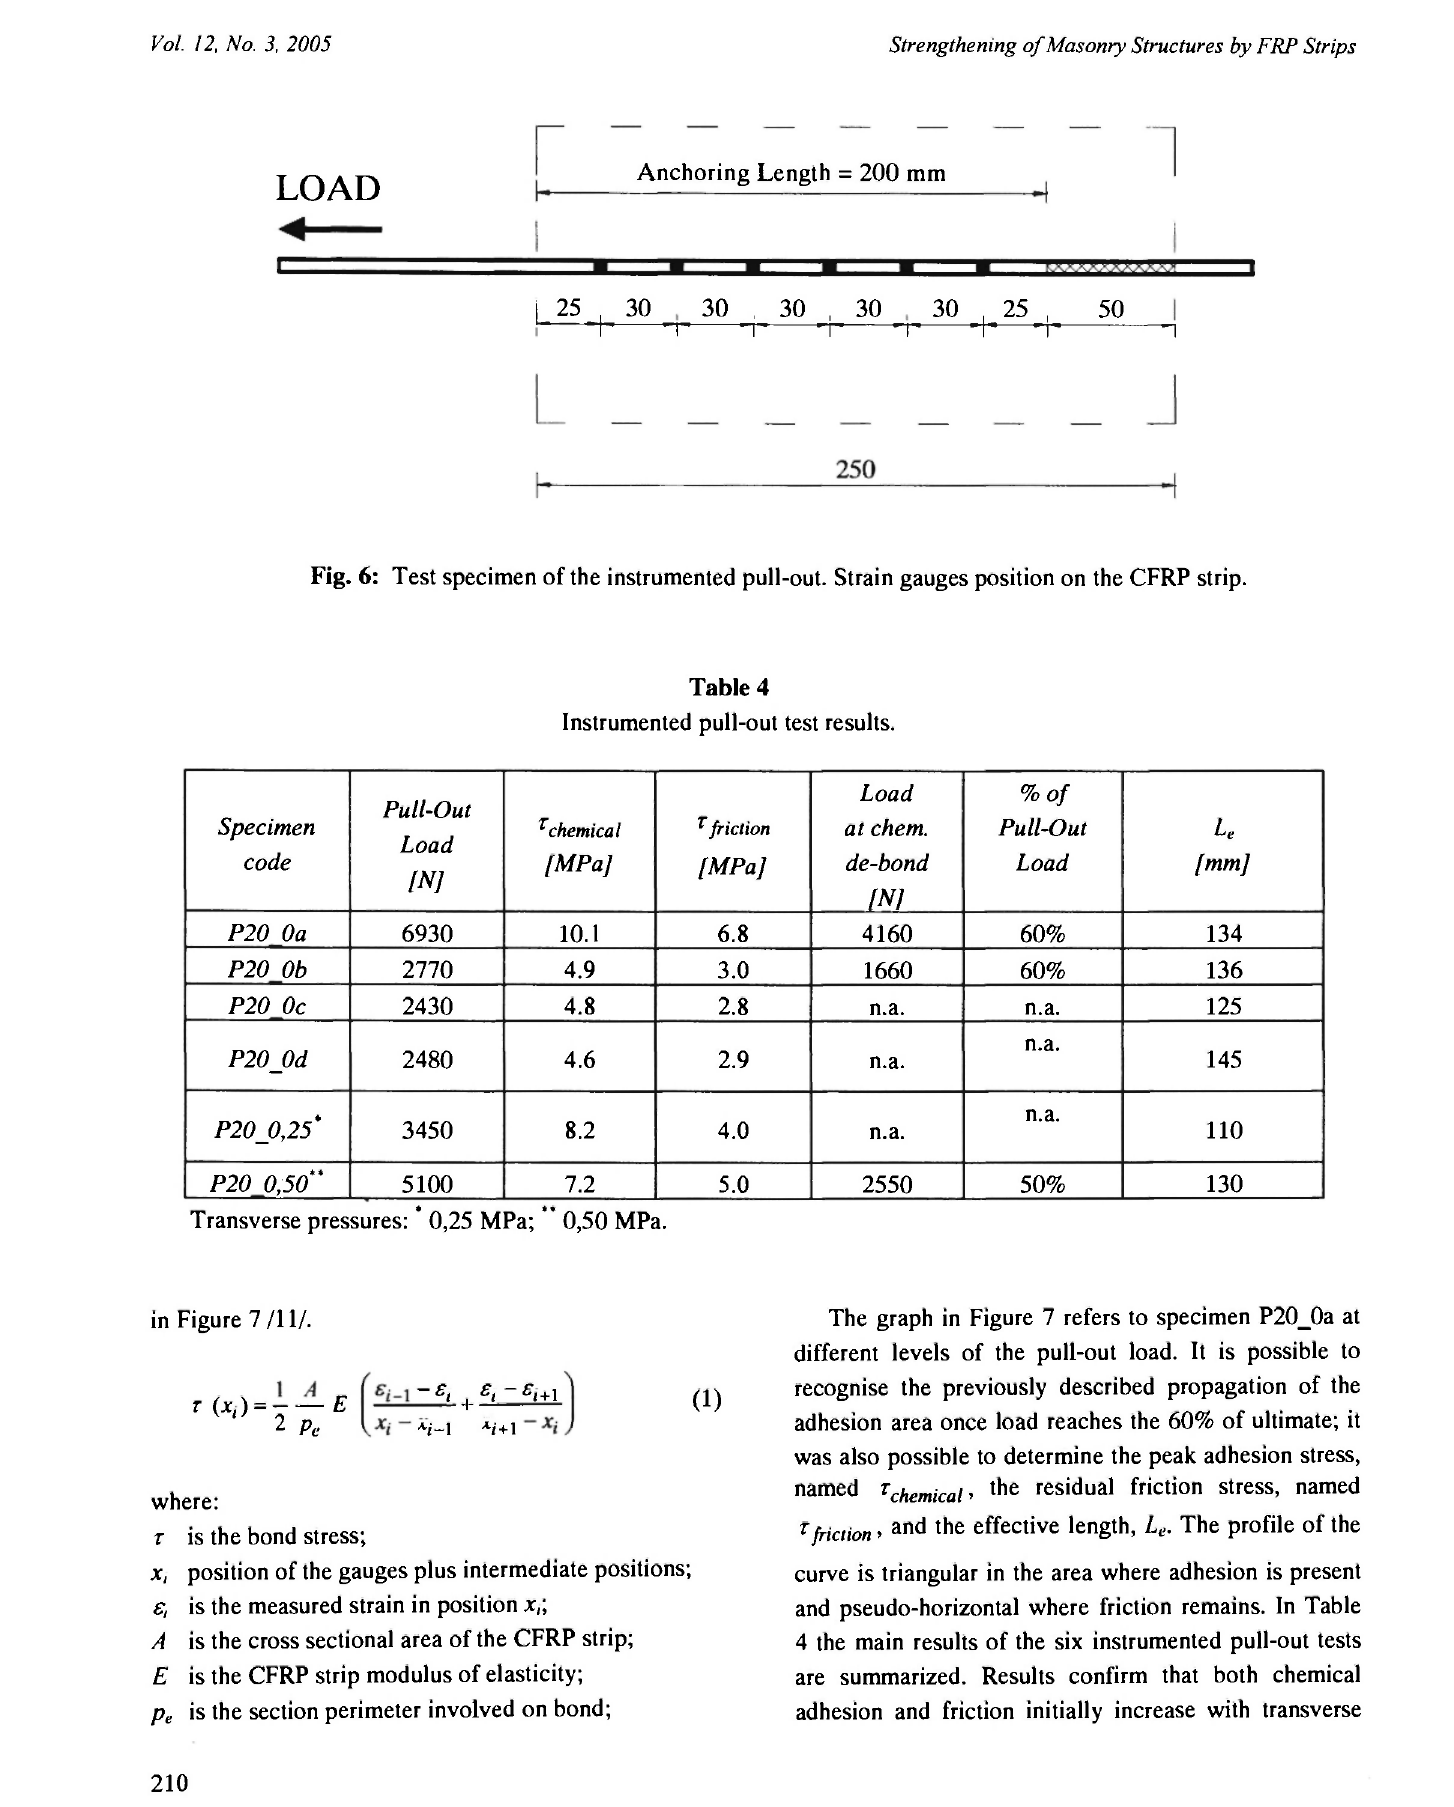
Fig. 6: Test specimen of the instrumented pull-out. Strain gauges position on the CFRP strip.